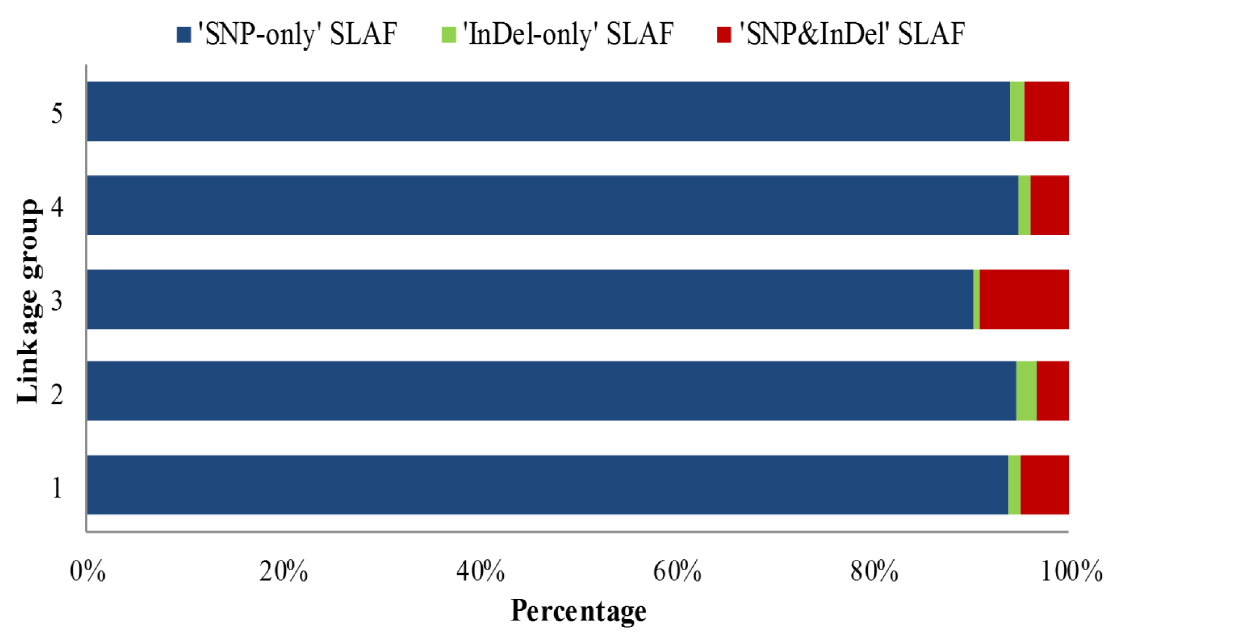
Fig 3. Percentages of diverse SLAF types on each linkage group.